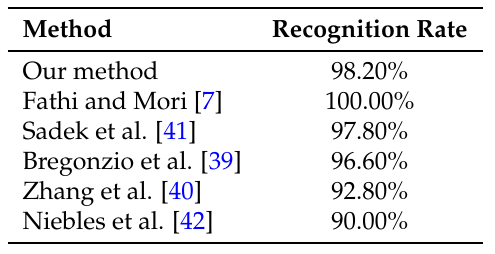
Table 2. Comparison with a number of related results reported in recent